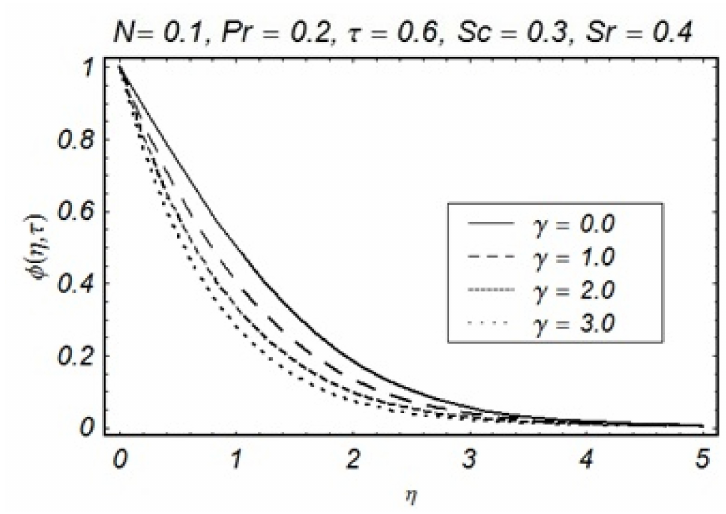
Figure 16. Indication of γ on solute profile.